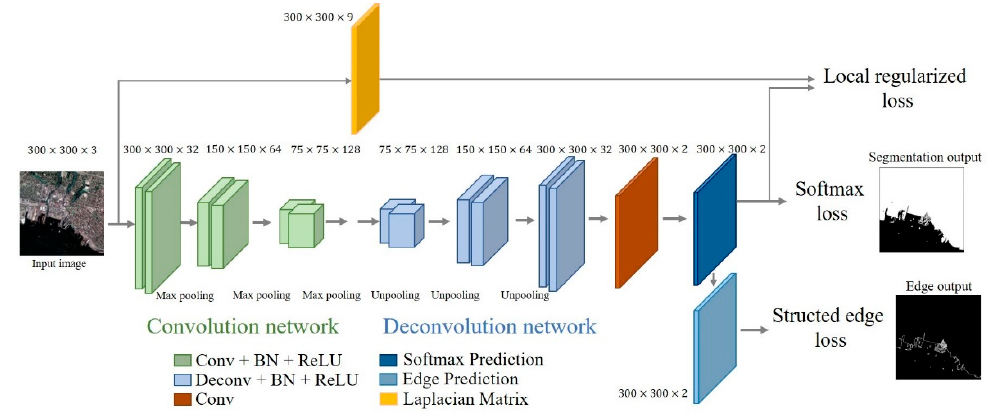
Figure 2. SeNet system architecture [5] .